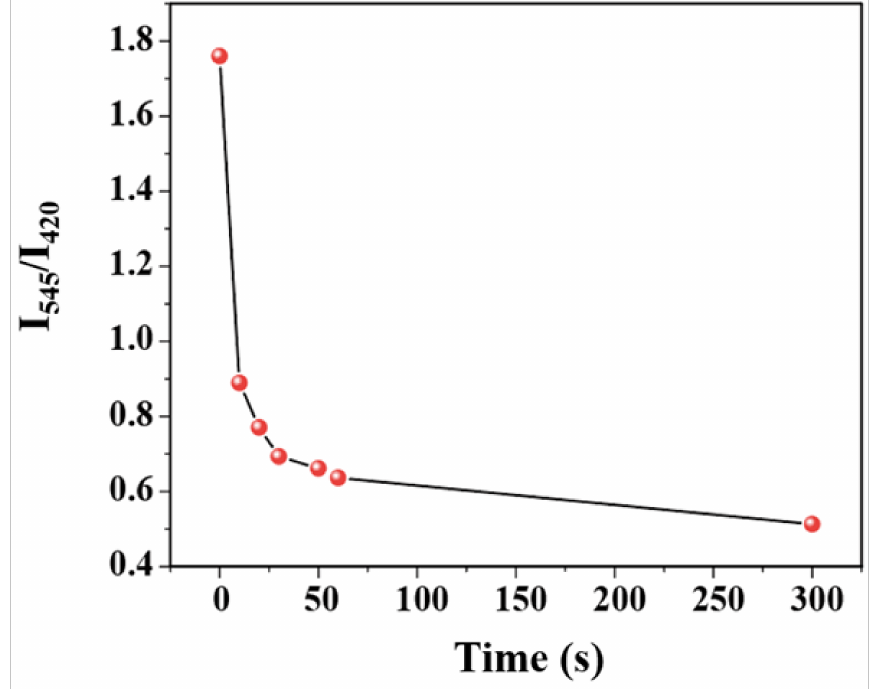
Figure 6. Function relationship between I 544 /I 420 ratio and immersion time after entering